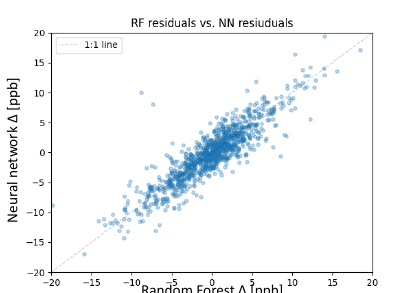
Figure 6. Scatter plot of the residuals ∆ of the random forest on the x-axis and neural network on the y-axis for the test